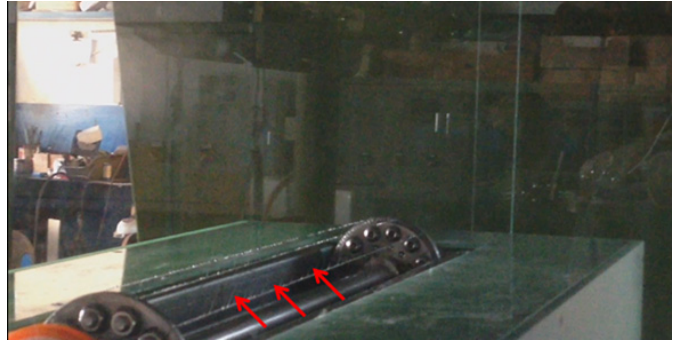
Figure 2. Image of electrospinning that administers a wire electrode.